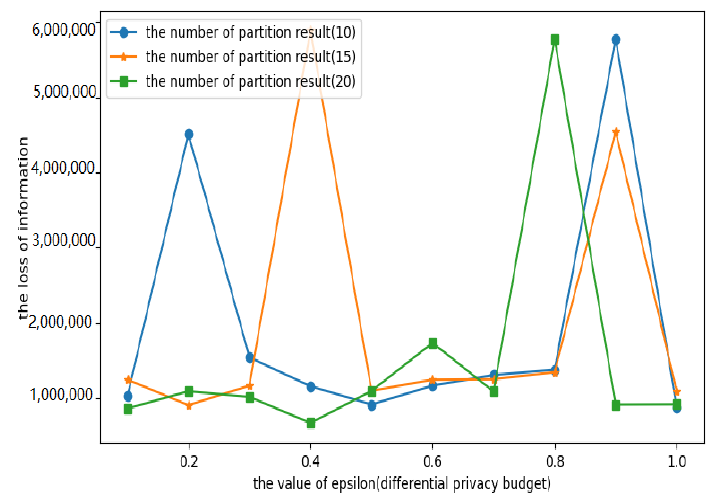
Figure 17. The information loss with different epsilon (T-drive